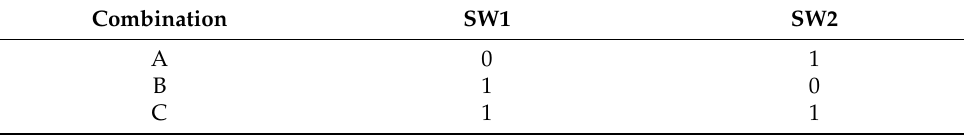
Table 5. Protection Zone Extra Branch Combinations (“1”: Connected, “0”: Not